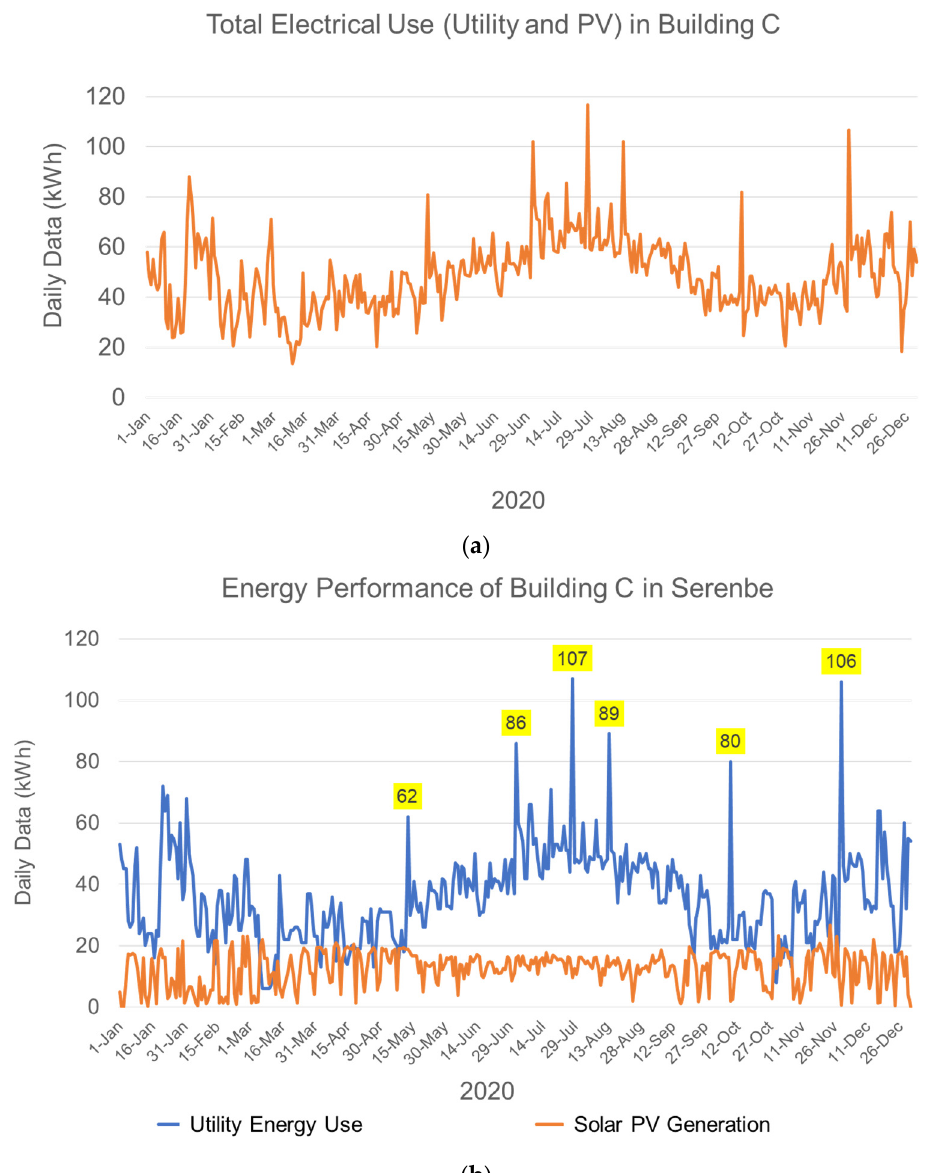
Figure 7. ( a ) Daily electrical use (utility electricity data plus PV generation) in building C from 1